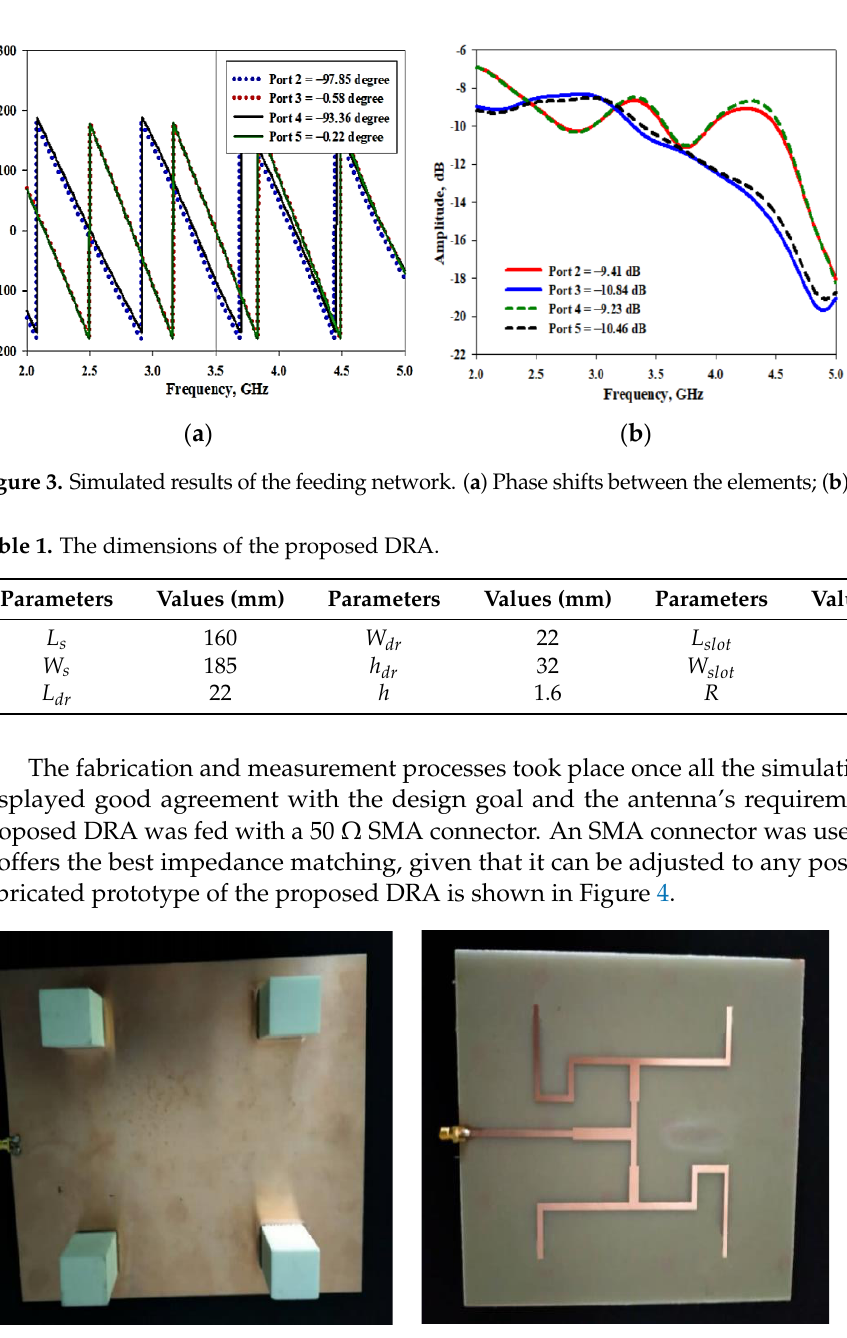
Figure 2. Feeding network. ( a ) Structure of the feeding network; ( b ) location of the ports.